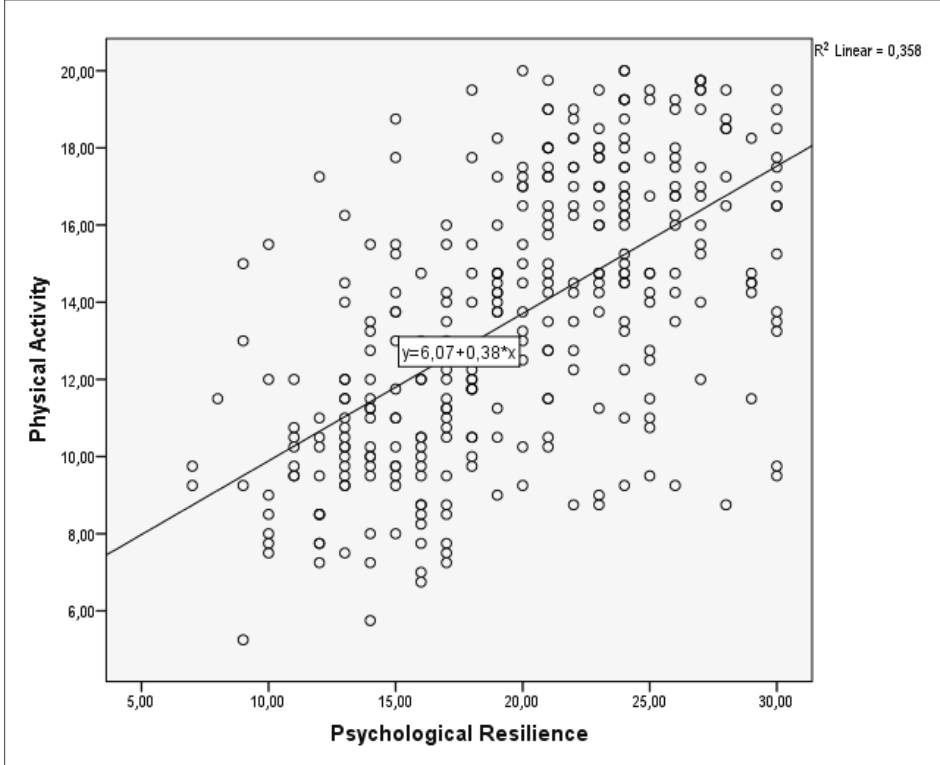
Figure. The relation- ship between physical activity and